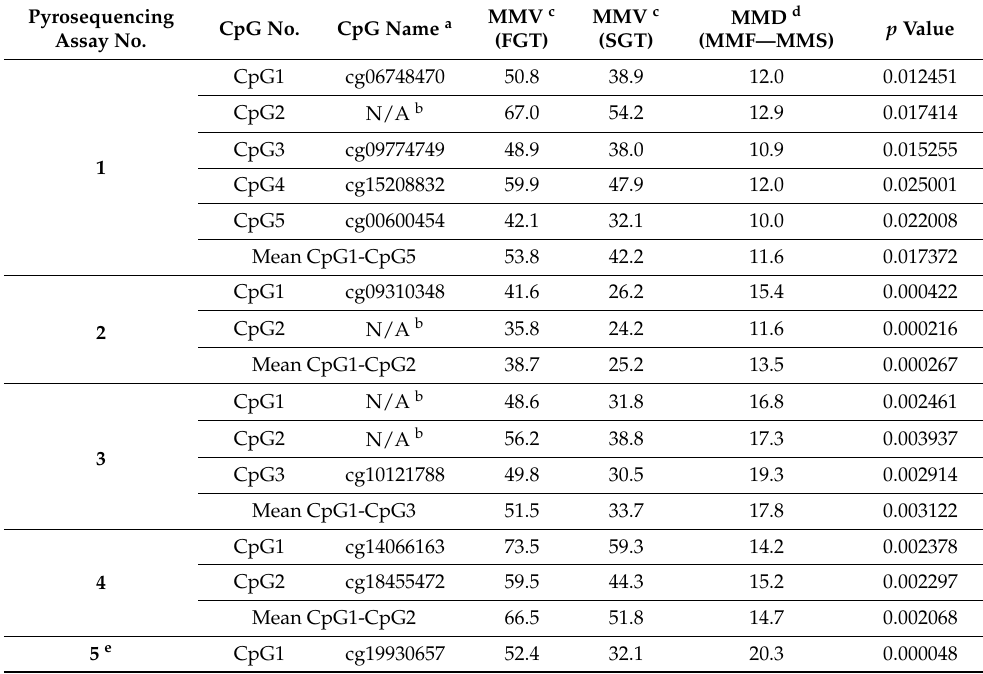
Table 1. The results of DNA bisulfite pyrosequencing analysis. Pyrosequencing Assay No.